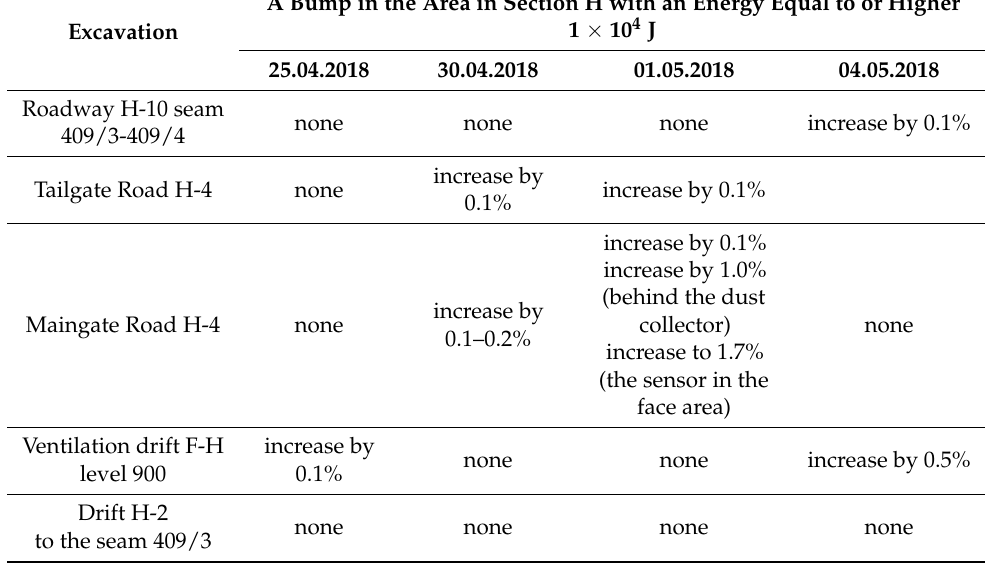
Table 1. The effect of the bumps on methane release into excavations in section H [3].